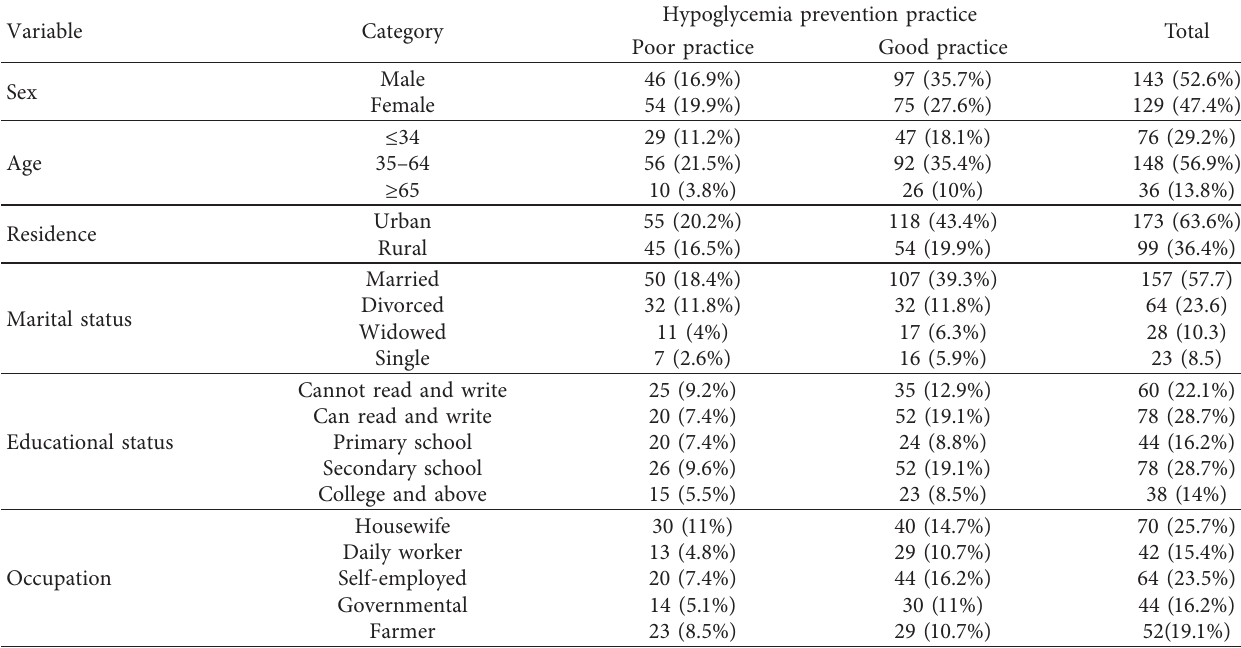
Table 1: Sociodemographic profile of the participants on practice in prevention of hypoglycemia among patients with diabetes mellitus at public hospitals of the central zone, Tigray, Ethiopia 2018.